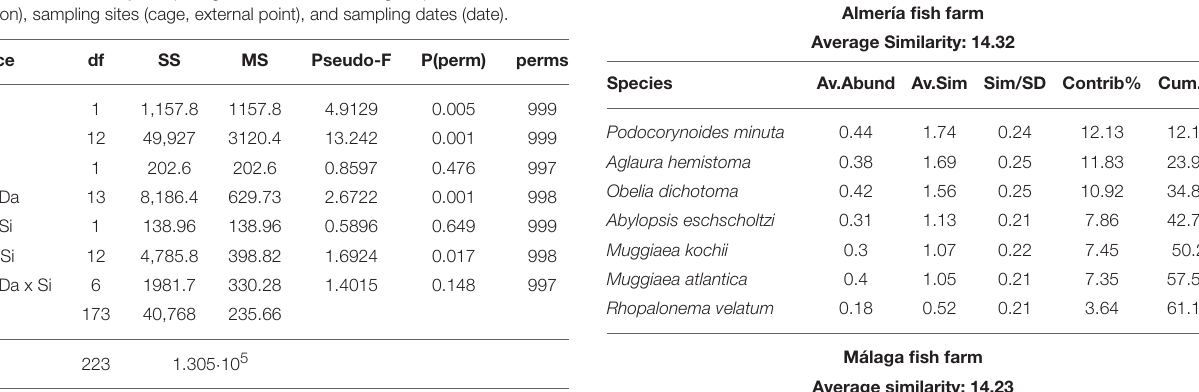
TABLE 2 | SIMPER analysis on cnidarian species at both facilities. Almería fish